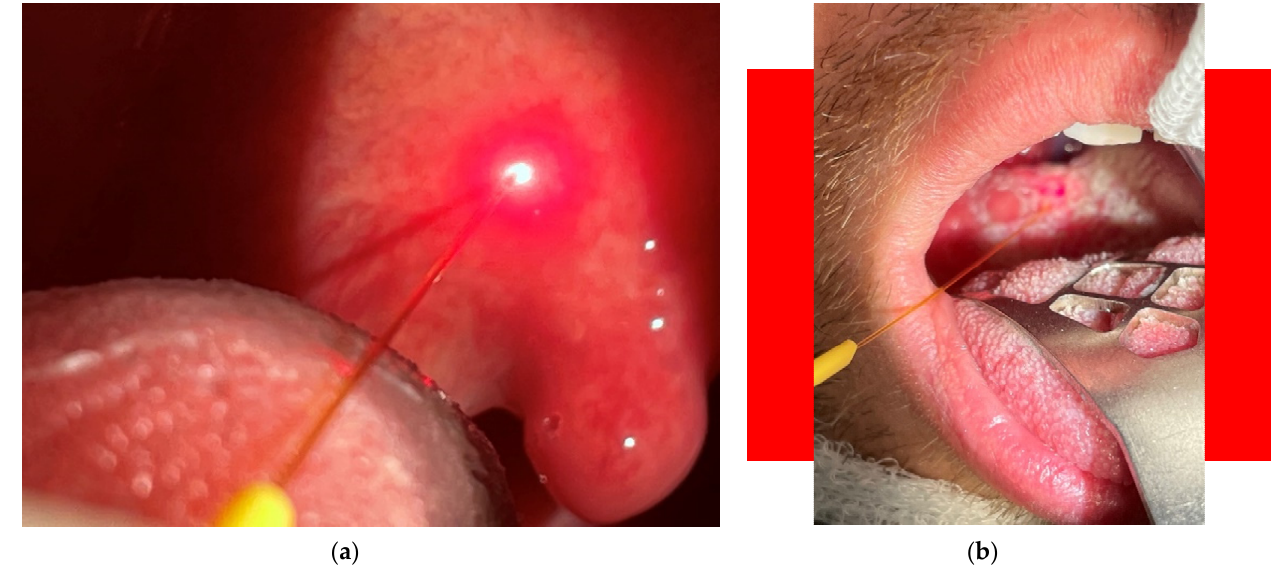
Figure 4. Laser-assisted (a) haemostasis and (b) surgery of